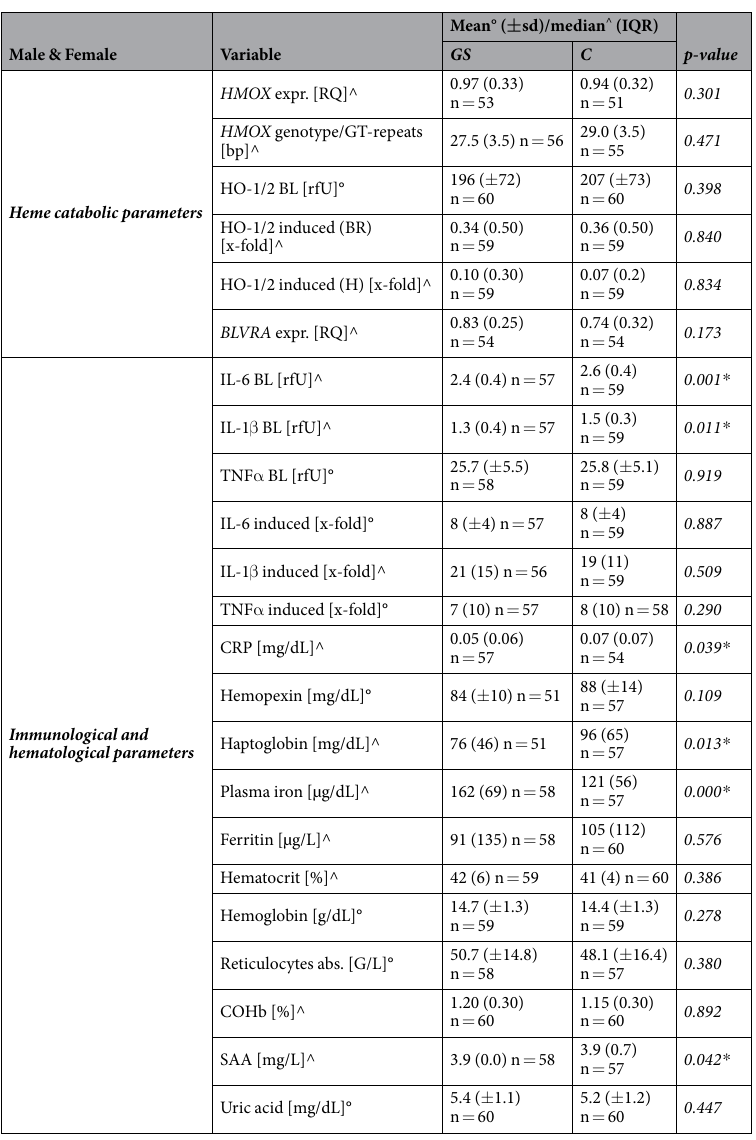
Table 1. Parameters of the heme catabolic pathway, immunology and hematology, including all (male and female) subjects from the BiliHealth study. Values are specified as applies according to distribution of data. For parametric variables, means° ± sd are shown, for non-parametric data, medians ^ (50 th percentiles) and inter- quartile range (IQR) are displayed. Comparison of means for parametric data or of ranks (for non-parametric data) was completed using independent samples t-test or Mann-Whitney-U-test. * p-value: significant on a 5% level of significance; T p-value: trend on a 10% level of trend. Abbreviations: GS: Gilbert’s syndrome; C: Controls; HMOX expr. [RQ]: Heme oxygenase gene expression as relative quantification [RQ to cDNA pool]; [bp] base pairs; HO-1/2 [rfU]: intracellular heme oxygenase in PBMCs [relative fluorescence]; HO-1/2 induced (BR)/(H): fold-increase in intracellular heme oxygenase, induced by incubation with unconjugated bilirubin (BR) or heme (H) overnight, relative to baseline; BLVRA expr.: Biliverdin reductase gene expression as relative quantification [RQ to cDNA pool]; IL-6 BL/IL-1 β BL/TNF α BL [rfU]: baseline (BL) intracellular (PBMCs) levels